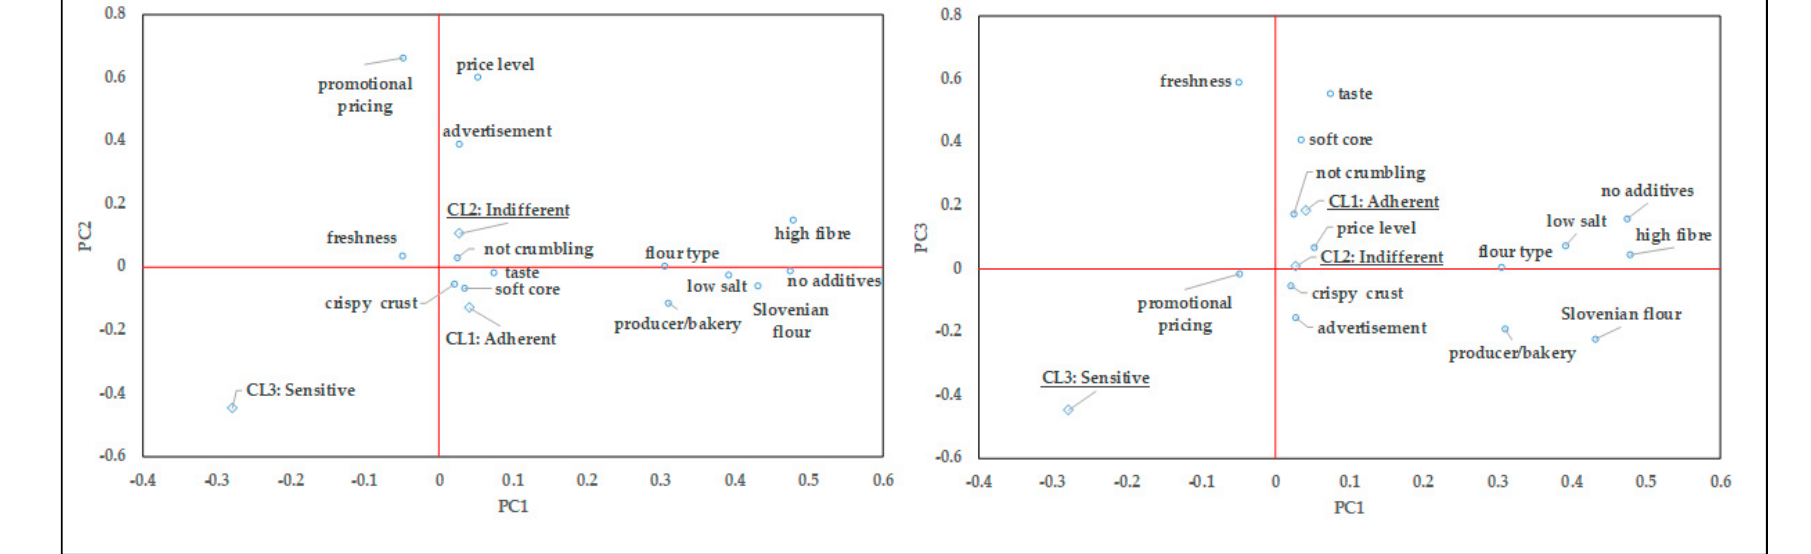
Figure 2. Loading plots of the principal component analysis for the variables related to the importance of extrinsic and intrinsic attributes in bread selection ( n = 200).